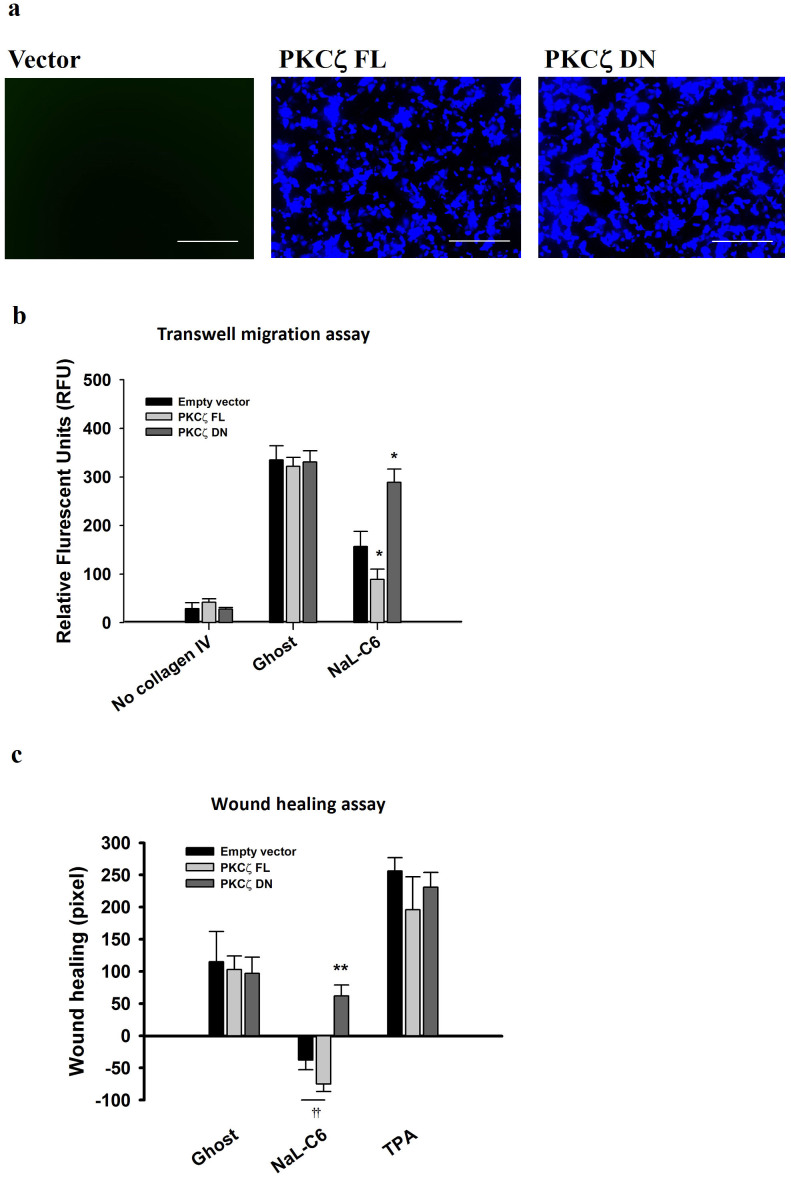
NaL-C6-mediated inhibition of MDA-MB-231 migration was dependent on functional activity of PKCζ.(a) Empty vector, PKCζ FL, or PKCζ DN were transfected into MDA-MB-231 cells. The transfection efficiency of these constructs was detected with anti-HA and anti-Alexa 350 staining. >95% cells received target genes. The migration of empty vector, PKCζ FL, or PKCζ DN transfected cells in response to NaL-C6 treatment was assessed by transwell migration assay (b) and wound healing assay (c). (b) For transwell migration assays, plasmid-transfected MDA-MB-231 cells were treated with ghost or 20 μM NaL-C6 for 30 min before being loaded into transwell inserts. Results were expressed as mean ± SEM. n = three replicates.*p < 0.05 compared with empty vector control. (c)PKCζ DN rescued suppressive effect of NaL-C6 on cell wound healing capacity. For wound healing assays, confluent cell monolayers in 6 well plates were scratched and the area (in number of pixels) that cells migrated into the wound over a period of 12 hr was measured. Plasmid-transfected MDA-MB-231 cells were treated with ghost liposome, 20 μM NaL-C6, or 200 nM TPA for 30 min before assay. Results were expressed as mean ± SEM. n = three replicates.**p < 0.01,††p < 0.01compared with NaL-C6+vec.